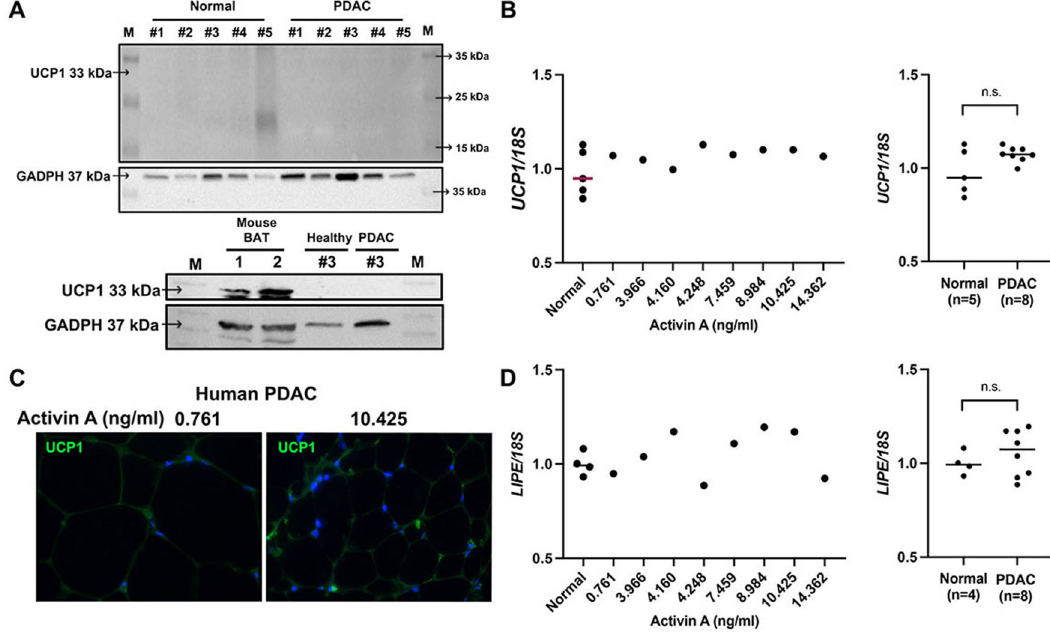
Figure 7. Visceral adipose tissue remodeling in PDAC patients does not rely on increased browning of white adipose tissue. ( A ) Immunoblotting with UCP1 (33 kDa) in visceral adipose tissue of non-cancer patients ( n = 5 ) and PDAC patients ( n = 5 ) (top). Immuoblotting with UCP1 in visceral adipose tissue of a non-cancer patient and a PDAC patient with intrascapular brown adipose tissue from a healthy control mouse as a positive control ( n = 2 ) (bottom). ( B ) Relative mRNA expression levels of UCP1 in visceral adipose tissue of non-cancer patients ( n = 5 ) and PDAC patients (left). Corresponding serum activin A levels are included in ng/ml. Statistical analysis of relative mRNA expression levels of UCP1 in visceral adipose tissue of non-cancer patients ( n = 5 ) and PDAC patients ( n = 8 ) (right). n.s., not significant. ( C ) Representative immunofluorescence images of UCP1 expression in visceral adipose tissue from patients with low and high circulating activin A levels included in ng/ml. Nuclei were stained with DAPI. ( D ) Relative mRNA expression levels of HSL (LIPE) in visceral adipose tissue of non- cancer patients and PDAC patients (left). Corresponding serum activin A levels are included in ng/ml. Statistical analysis of relative mRNA expression levels of LIPE in adipose tissue of non-cancer patients ( n = 4 ) and PDAC patients ( n = 8 ) (right). n.s., not significant.